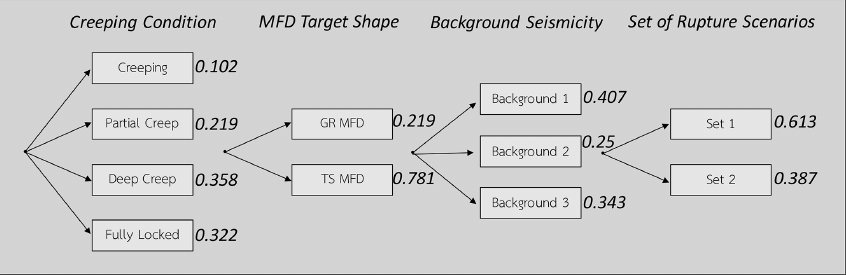
Figure 12. Weighted logic tree established in this study. For each branch, the scaling law parameters and the slip-rate uncertainties are explored through 10 random samples. The weight of each branch is indicated by the bold